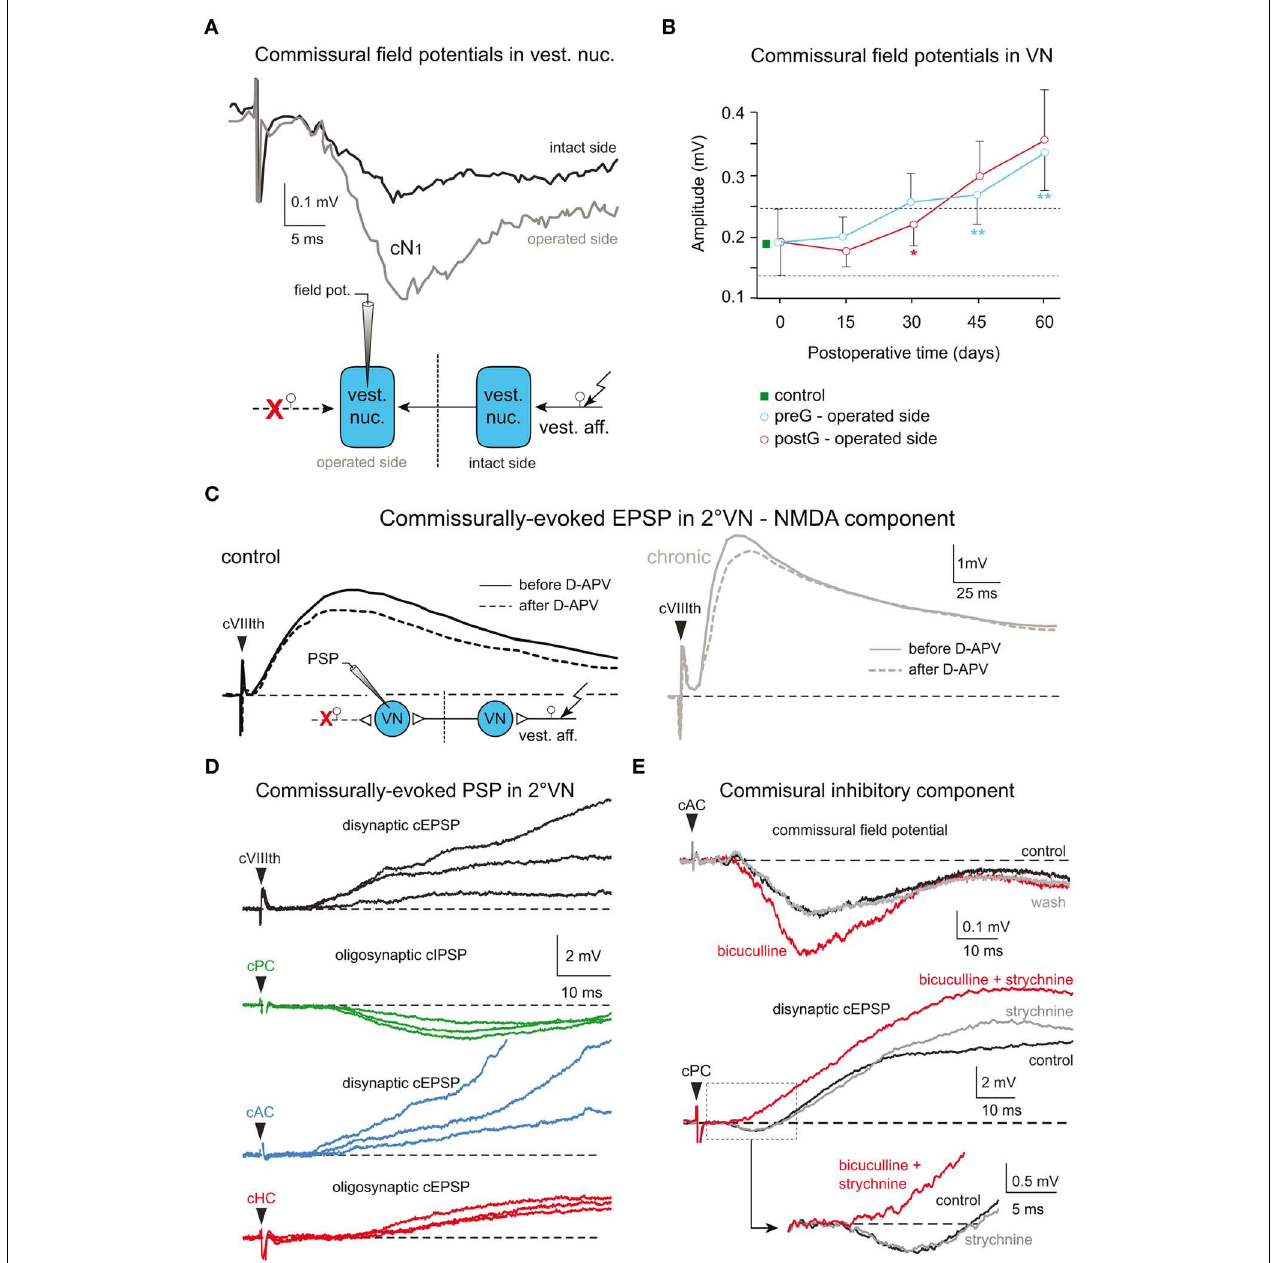
on the operated side of chronic UL frogs; modified and adapted from Knöpfel and Dieringer (1988). (D) Commissural vestibular responses recorded in vitro in an identified 2˚ anterior vertical semicircular canal (AC) neuron following electrical stimulation of the entire contralateralVIIIth nerve (black trace) or individual branches to the contralateral posterior canal (PC, green trace), AC (blue trace), and horizontal canal (HC, red trace). (E) Sensitivity of contralateral semicircular canal (cAC, cPC) nerve-evoked vestibular commissural field potentials (upper traces) and commissural EPSPs in 2˚VN (lower traces) to in vitro bath-applied antagonists that block the GABAergic (5 μ M bicuculline) and glycinergic (2 μ M strychnine) transmission; note the increase in amplitude of extra- and intracellular recorded responses. (D,E) Modified and adapted from Malinvaud et al.